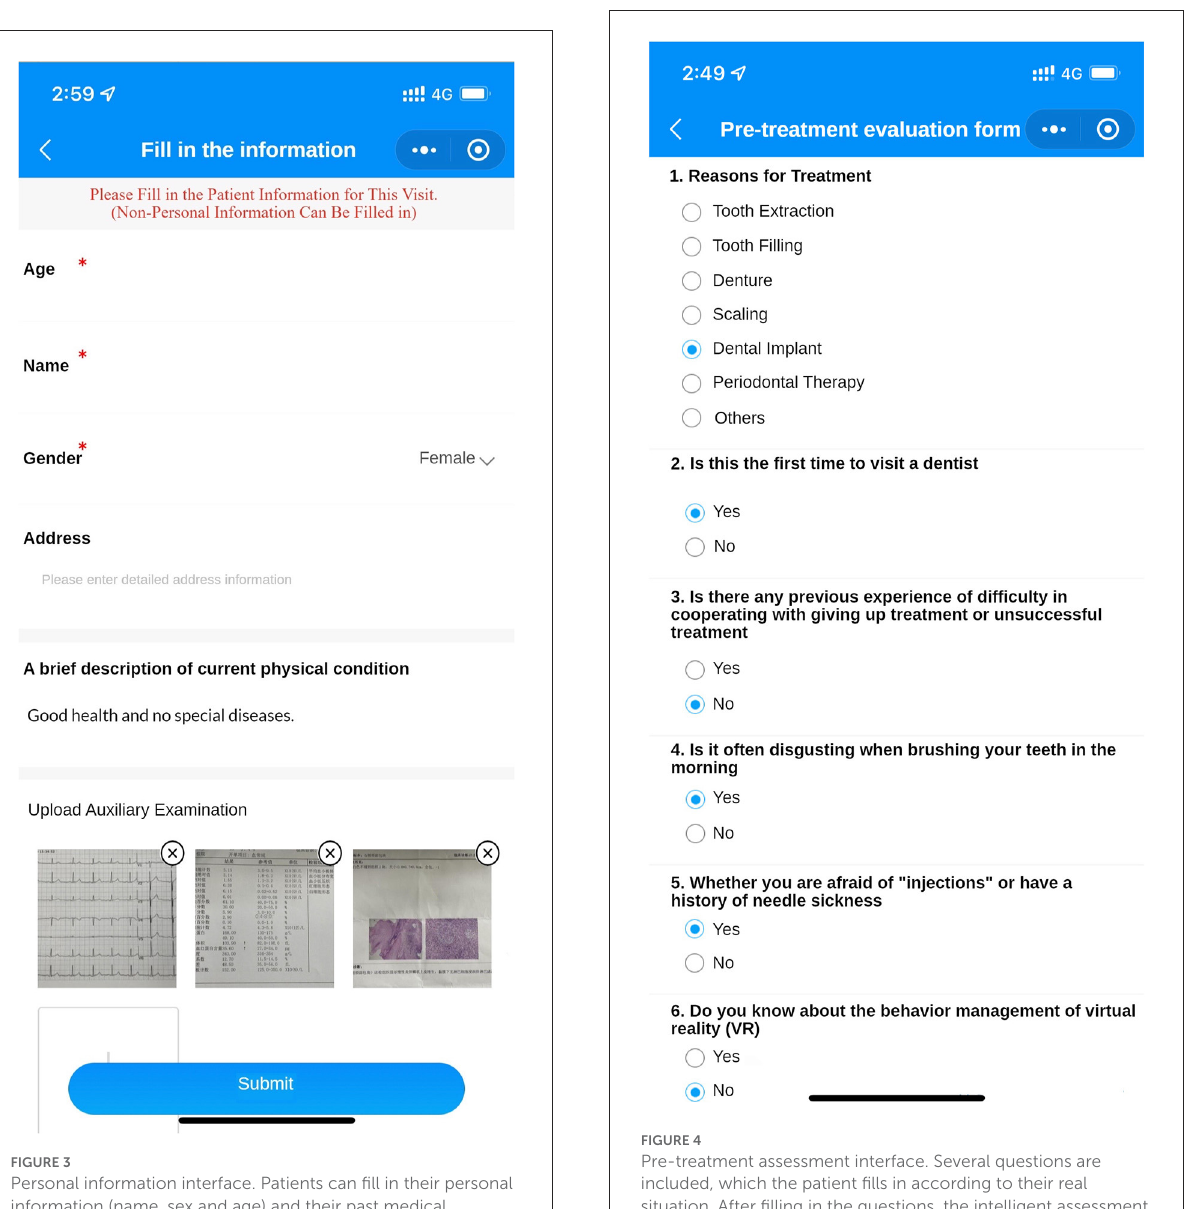
FIGURE4 Pre-treatment assessment interface. Several questions are included, which the patient fills in according to their real situation. After filling in the questions, the intelligent assessment system will send the assessment results and risk prediction to the doctor’s